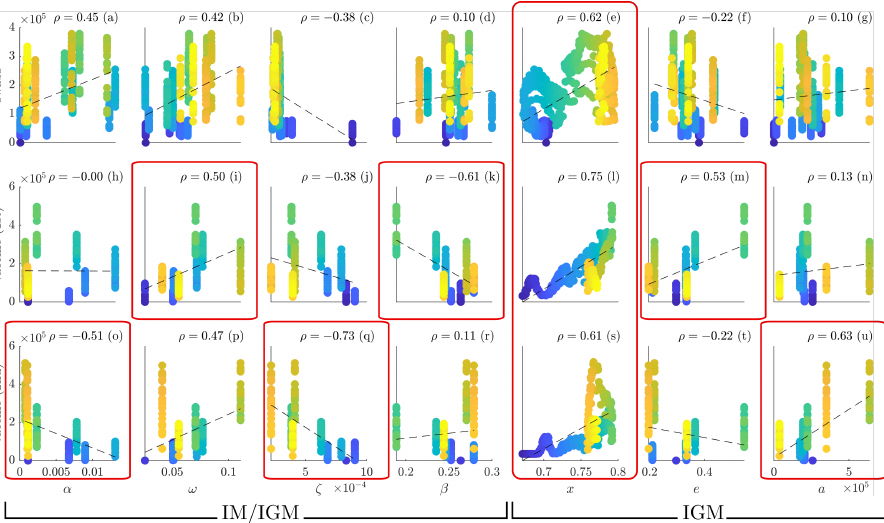
Figure 10. Scatter plots of the number of daily swabs (subplots ( a – g )), 1st vaccine (subplots ( h – n )) and 2nd vaccine (subplots ( o – u )) dose administrations ( y -axis) versus α , ω , ζ , β , x , e and a ( x -axis). The colors indicate the time flow (blue for the first days, yellow for the last). The corresponding regression lines are reported (dashed black), as well as the correlation coefficients ρ . Most significant correlations ( | ρ | > 0.5) are highlighted in